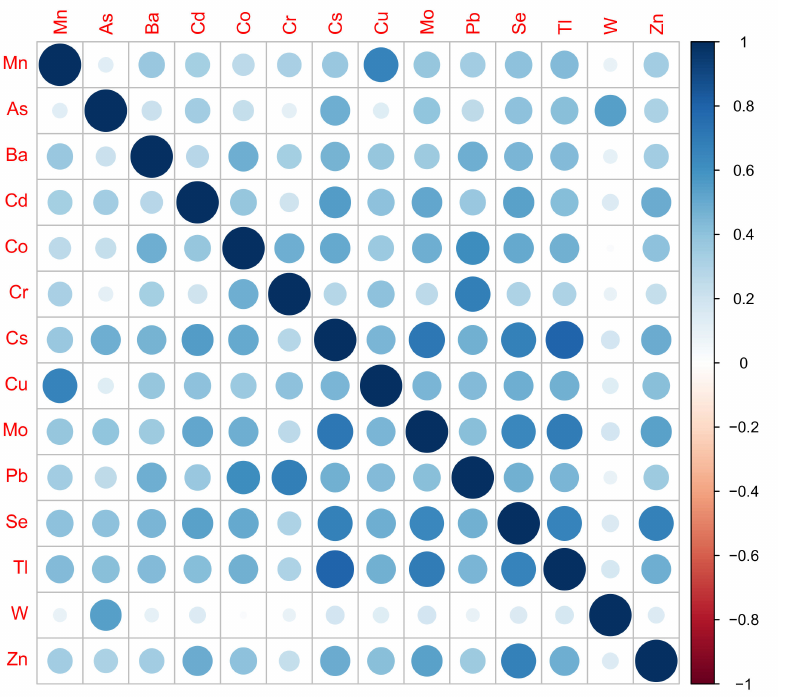
Figure 1. Spearman rank correlations among metals included in this analysis ( n = 1478). Larger circles indicate larger magnitude of correlations. Color of circles indicates magnitude and direction of